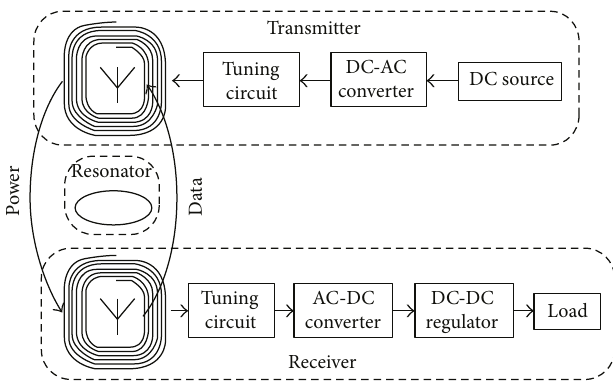
Figure 2: Model of WPT system for a biomedical